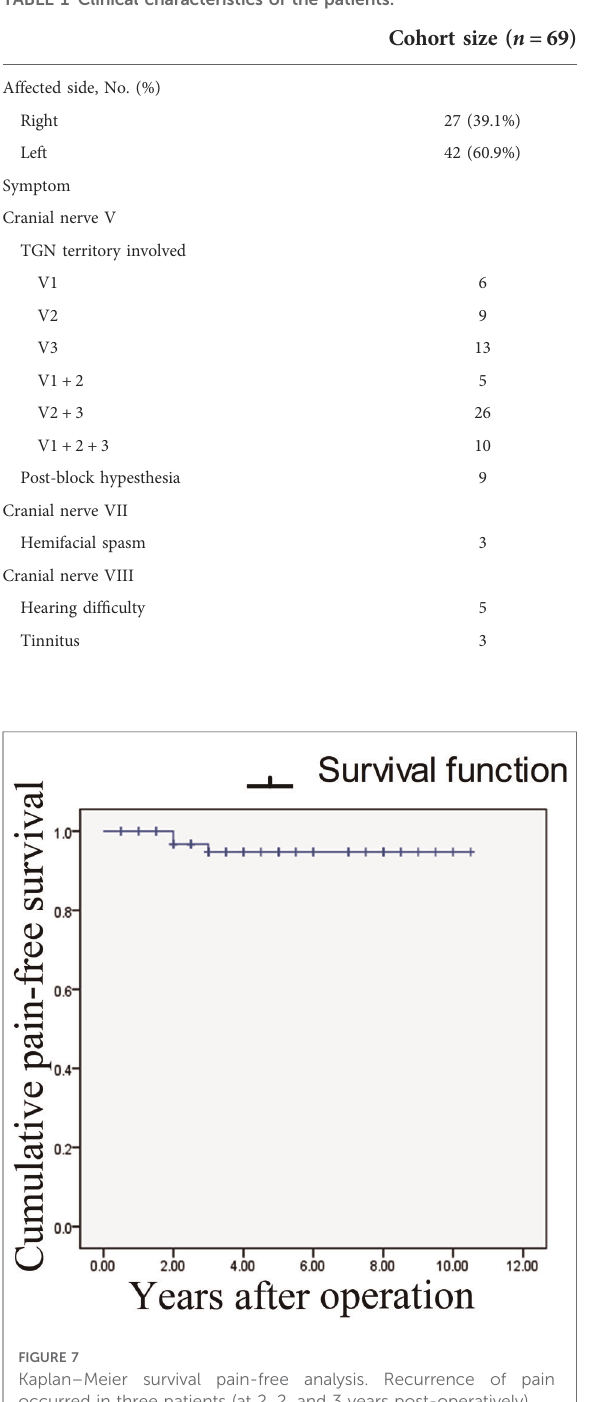
TABLE 1 Clinical characteristics of the patients.